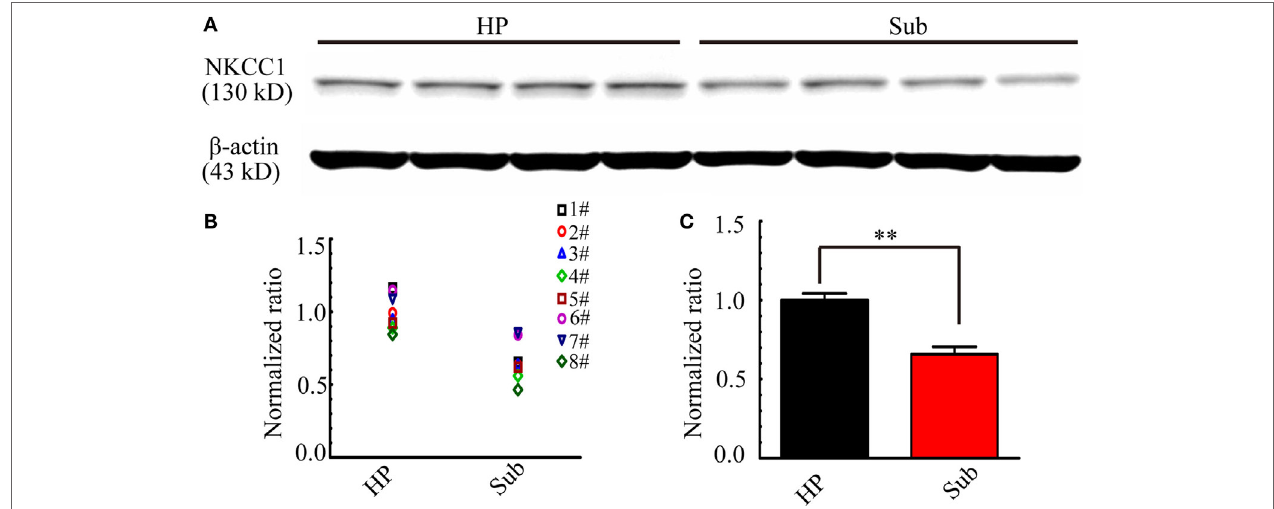
FigUre 10 | na + –K + –2cl − cotransporter 1 (nKcc1) expression level in the hippocampus proper (hP) and the subiculum . (a) One example of Western blots of the NKCC1 in the HP and the subiculum (Sub). (B,c) Protein levels were quantified by densitometric signals obtained from Western blots, the level of NKCC1 protein in the subiculum were normalized to this protein level in the HP. The normalized protein levels in each mouse were displayed in (B) , and the averaged normalized protein levels of eight mice were displayed in (c) . The level of NKCC1 protein was significantly higher in the HP than that in the subiculum (** P < 0.01, paired t -test, n =